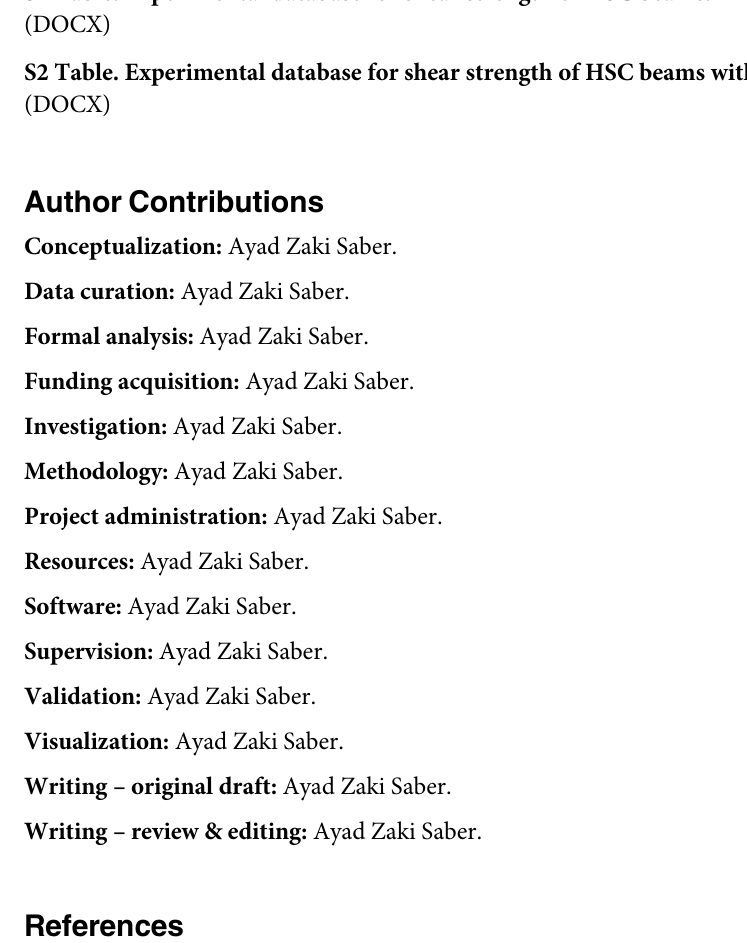
S1 Table. Experimental database for shear strength of HSC beams. S2 Table. Experimental database for shear strength of HSC beams with steel